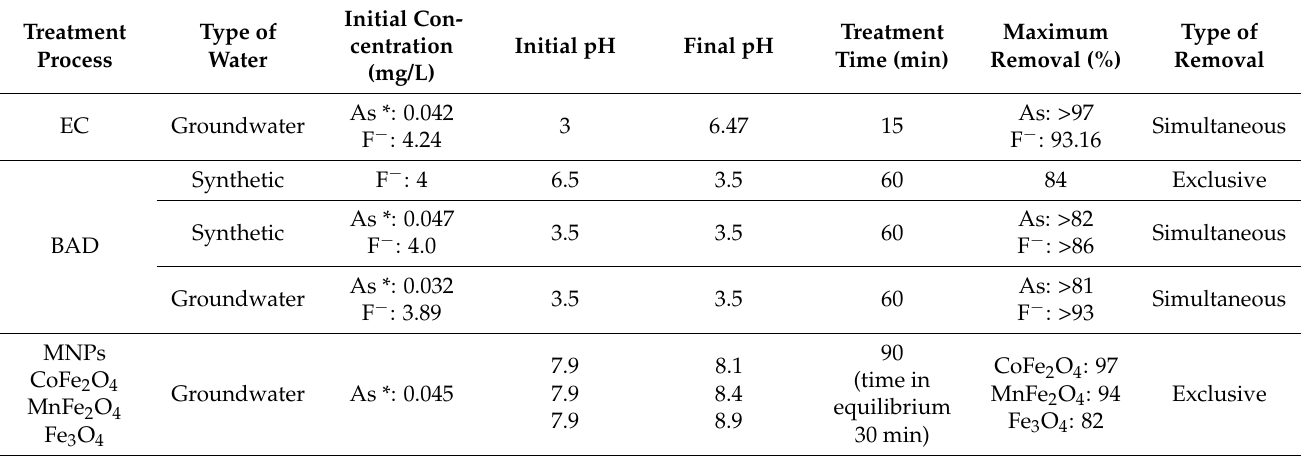
Table 3. As and/or F − removal by the three alternative methods